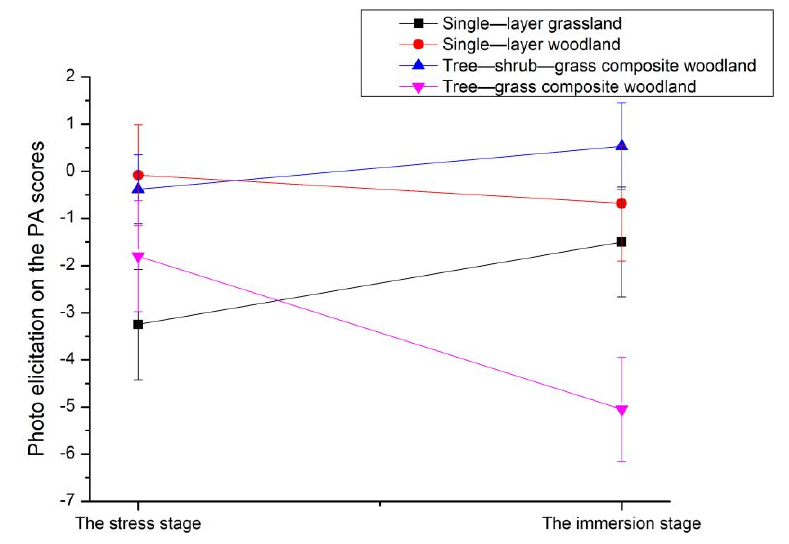
Figure 9. Effect of photo elicitation on the PA scores of participants.